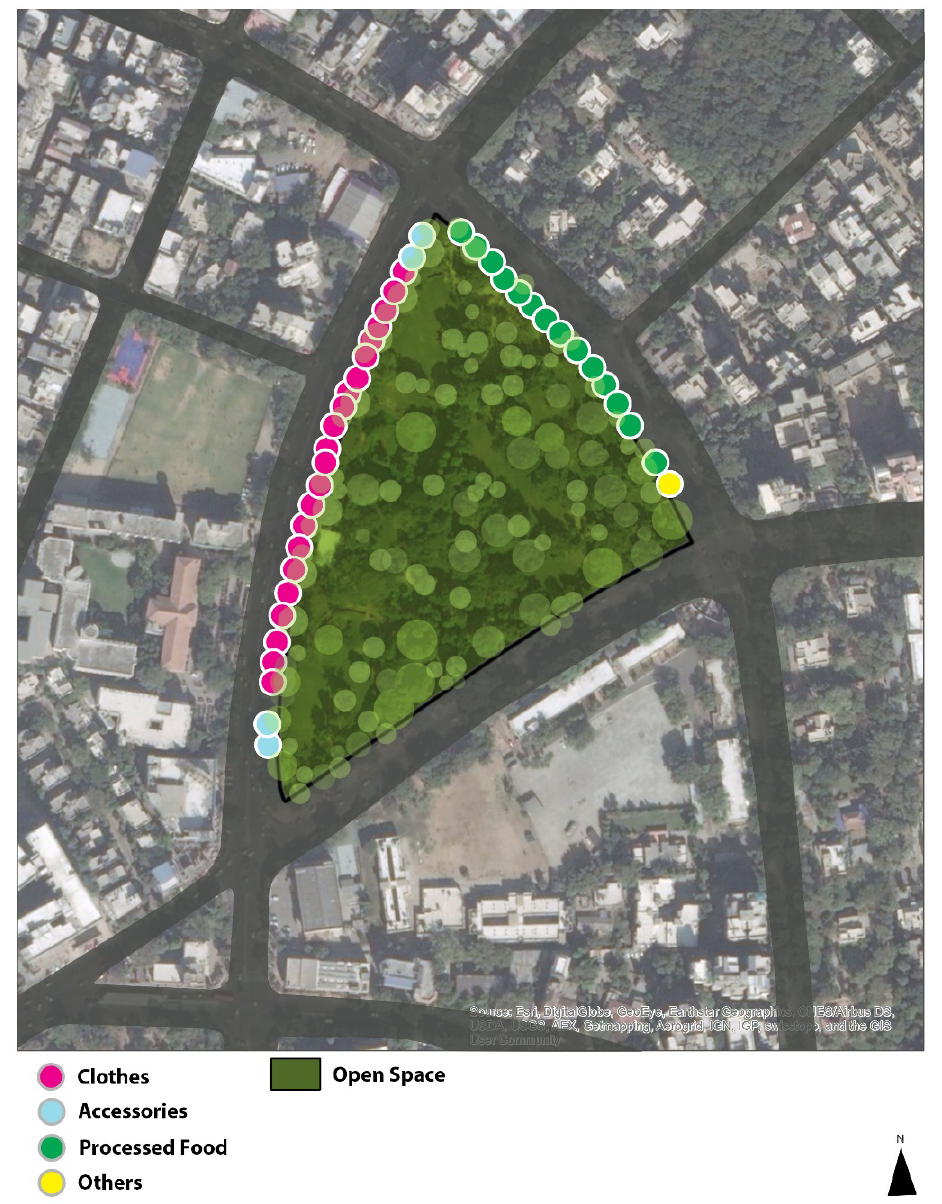
Figure 3. Street vendors around Vasna local garden. Source: Field